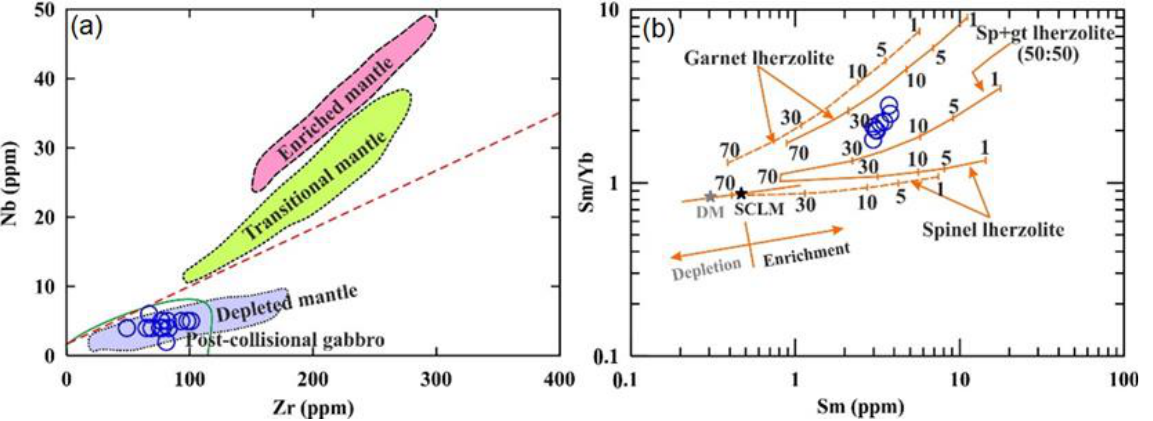
Figure 7. ( a ) Zr – Nb diagram [57] . Post-collisional gabbro field is used for comparison [8,10] ; and Figure 7. ( a ) Zr–Nb diagram [57]. Post-collisional gabbro field is used for comparison [8,10]; and ( b ) Sm/Yb vs. Sm diagram [61] , showing melt curves for different starting materials (garnet lher- ( b ) Sm/Yb vs. Sm diagram [61], showing melt curves for different starting materials (garnet zolite, spinel + garnet lherzolite, and spinel lherzolite) based on the non-batch melting equations of Shaw [62] . The dashed and solid curves represent the melting trends for depleted mantle (DM, Sm = 0.3 ppm and Sm/Yb = 0.86; [63] ) and enriched subcontinental lithospheric mantle (SCLM, Sm = 0.6 ppm and Sm/Yb = 0.96; [64] ), respectively. Partition coefficients are from McKenzie and O’Nions [63] . The numbers refer to the degrees of partial melting.